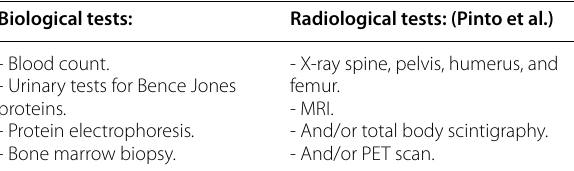
Table 1 Most important tests in eliminating a differential diagnosis of extramedullary plasmacytoma Biological tests: